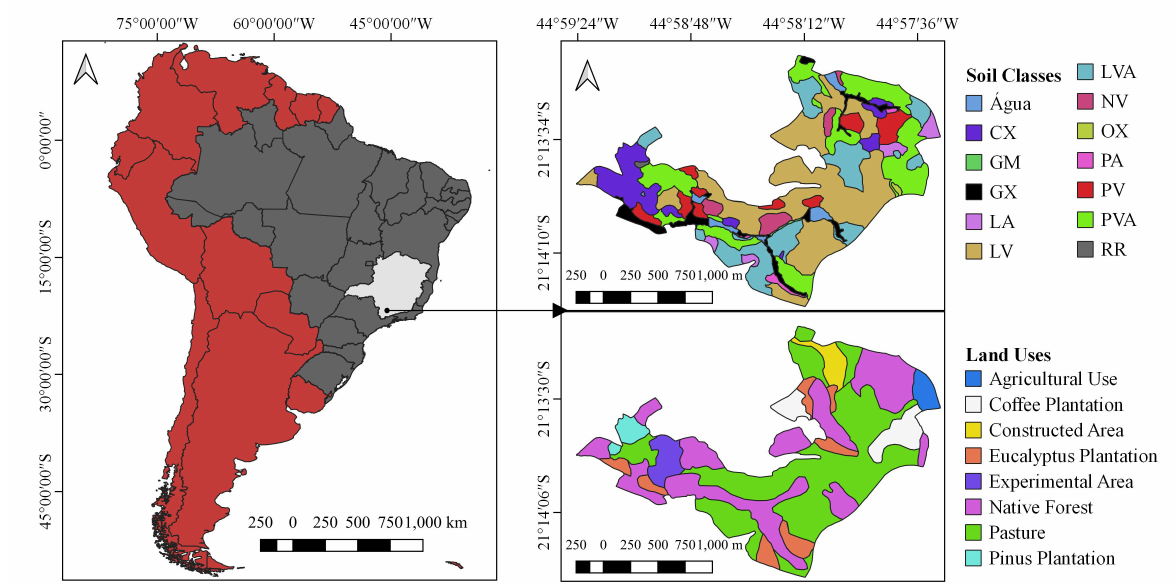
Figure 1. Geographic location of the study area, at the city of Lavras, state of Minas Gerais, Brazil, soil classes and land uses. CX – Haplic Cambisol, GM – Melanic Gleysol, GX – Haplic Gleysol, LA – Yellow Latosol, LV – Red Latosol, LVA – Red-Yellow Latosol, NV – Red Nitosol, OX – Haplic Organosol, PA –Yellow Argisol, PV – Red Argisol, PVA – Red-Yellow Argisol, RR – Regolithic Neosol.